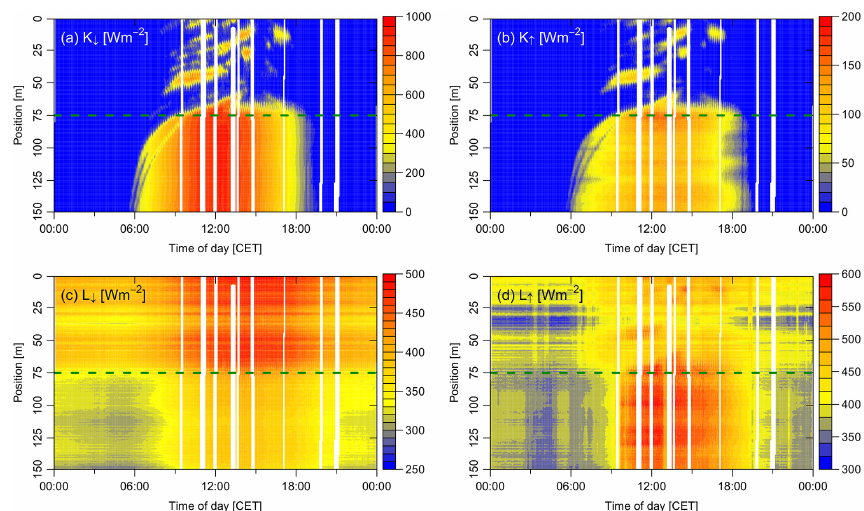
Figure 6. Complete horizontal profile for the whole of 28 June 2011 for all measured quantities. (a) shows the downwelling short-wave radiation ( K ↓ ) and (b) the upwelling short-wave radiation ( K ↑ ). (c) shows the downwelling long-wave radiation ( L ↓ ) and (d) the upwelling long-wave radiation ( L ↑ ). Remark: the scaling of the four radiation components is different in the four graphs. Position shows distance from the starting point in metres, with the starting point in the forest (0m), forest edge (75m, horizontal green dotted line) and endpoint at the clearing